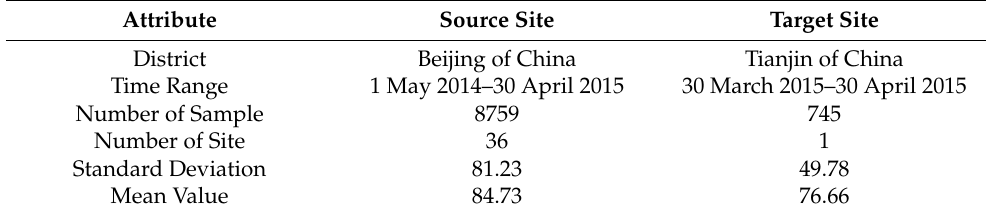
Table 1. Dataset